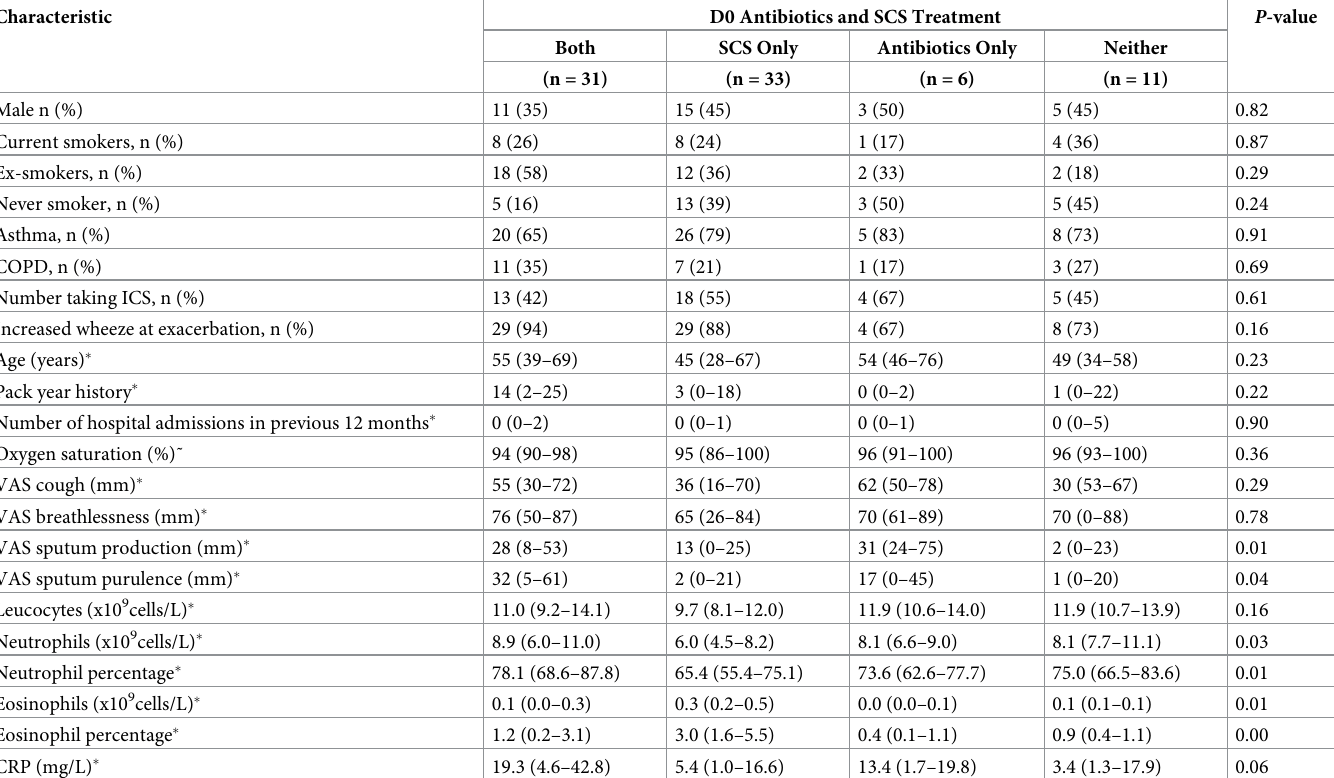
Table 2. Comparison of characteristics of participants given SCS only versus participants given antibiotics only versus participants given both SCS and antibiotics versus participants given neither SCS nor antibiotics. Characteristic